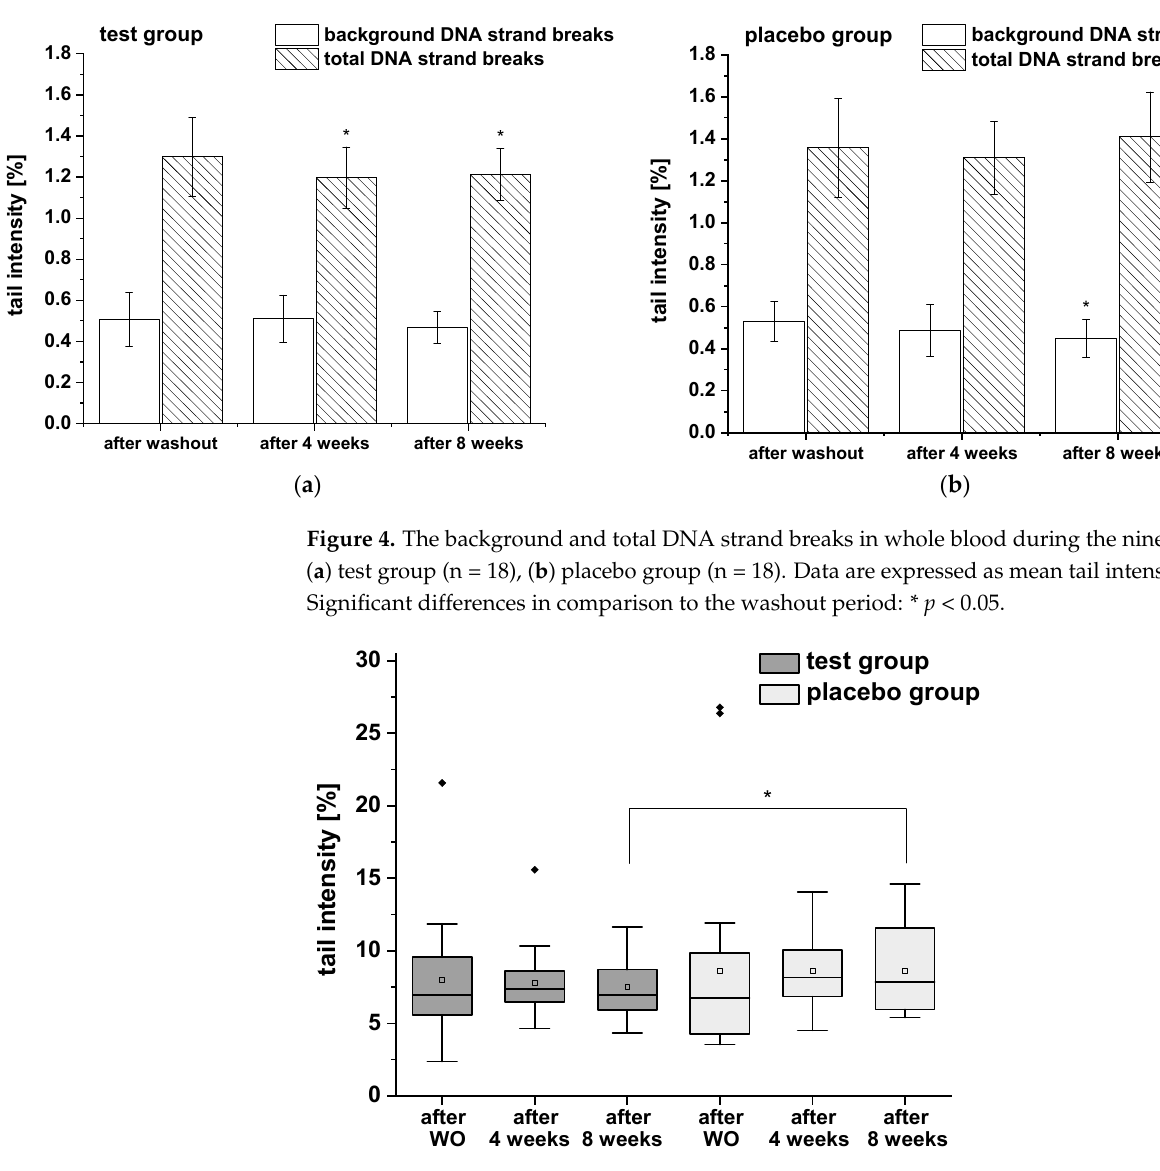
Figure 5. H 2 O 2 -induced DNA strand breaks (with formamidopyrimidine-DNA glycosylase (FPG) treatment) in isolated peripheral blood lymphocytes after the washout (WO) period, after four and eight weeks of intervention. Data are expressed as mean tail intensity [%] ± SD. Squares represent mean values; horizontal lines within the boxes represent median values; rhombuses represent outliers. * p <